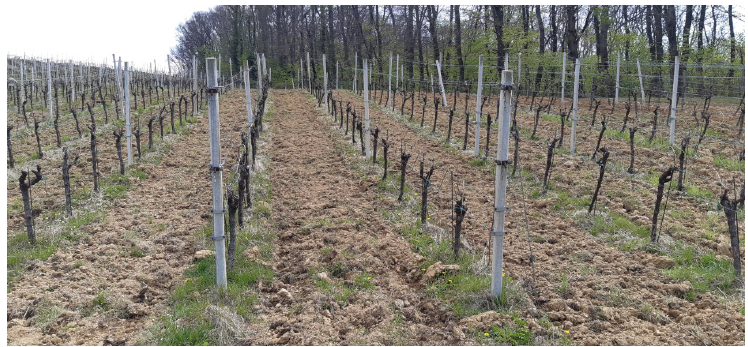
Figure 5. The use of concrete columns and wire joints and supports for vine